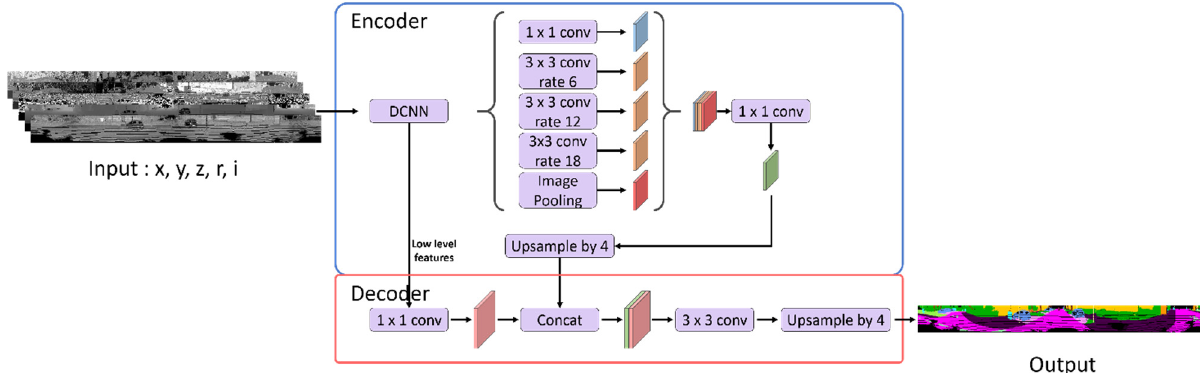
Figure 8. Network structure.